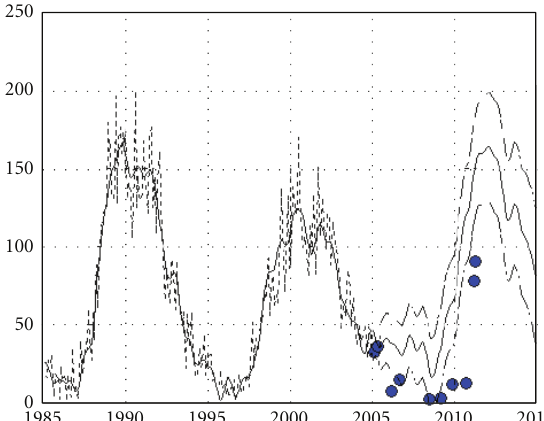
Figure 1: Model, prediction, and epignosis of the monthly mean Ri pattern. Dotted line demonstrates the real data. Dashes show the one sigma intervals. Blue dots are principal epignosis control marks. Abscissa axis fix years of the last modeled and predicted intervals. Ordinate axis shows international sunspot number